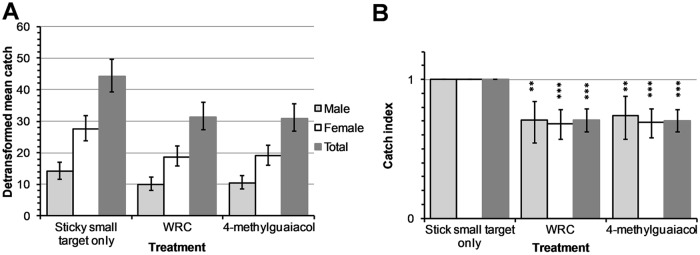
WRC and 4-methylguaiacol dispensed from two and one polyethene sachet respectively at sticky small targets.Detransformed means (A) and indices (B) of G. f. fuscipes catches. Error bars indicate 95% CI of the detransformed mean (A) and indices (B) of tsetse fly catches. **P<0.01 and ***P<0.001.